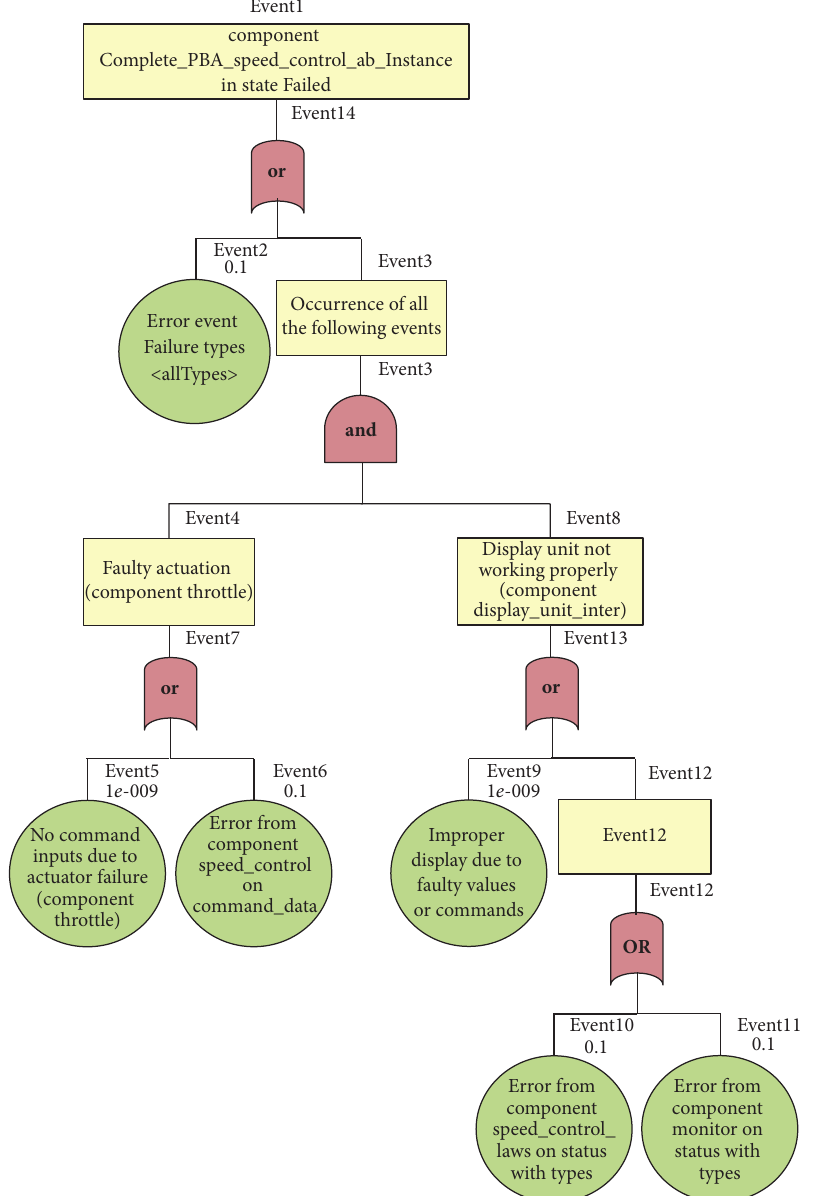
Figure 3: FTA view for PBA Speed Control Unit in OpenFTA.